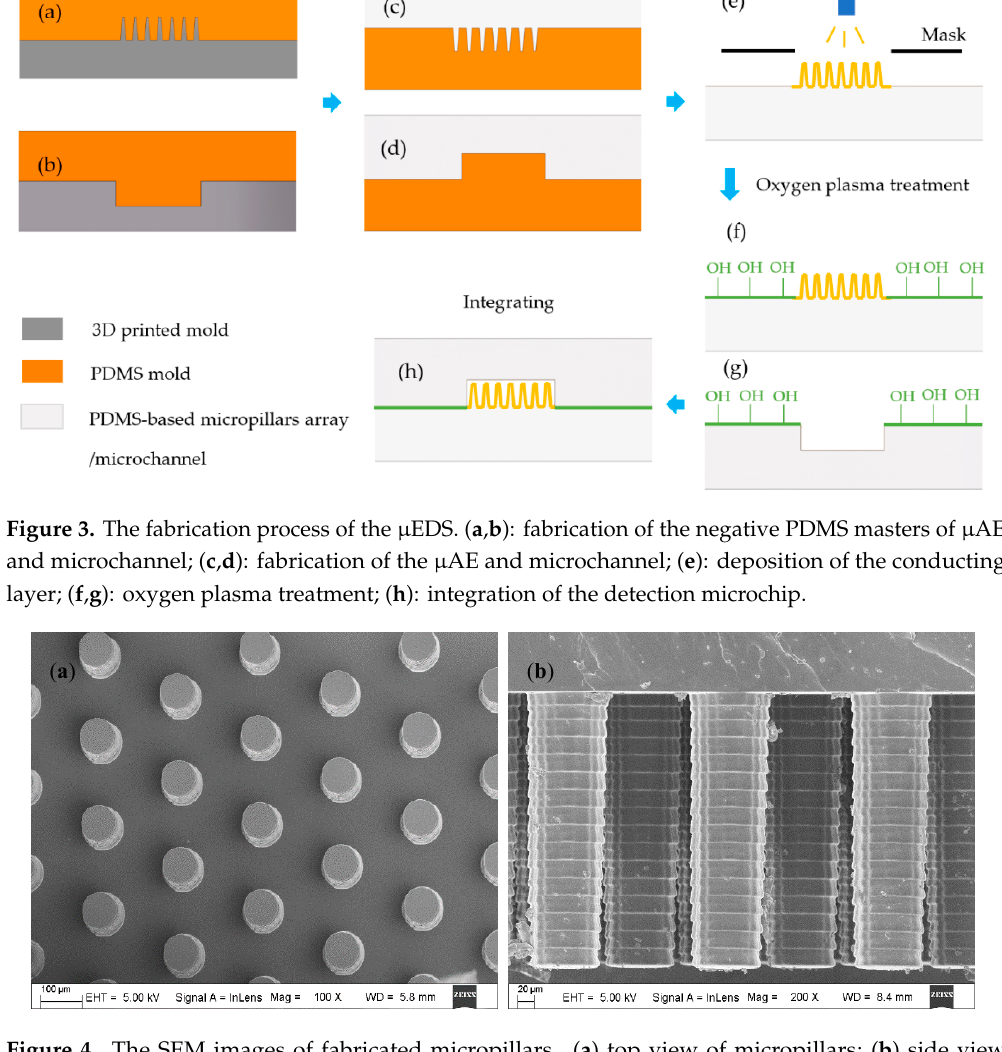
Figure 4. The SEM images of fabricated micropillars. ( a ) top view of micropillars; ( b ) side view of micropillars.